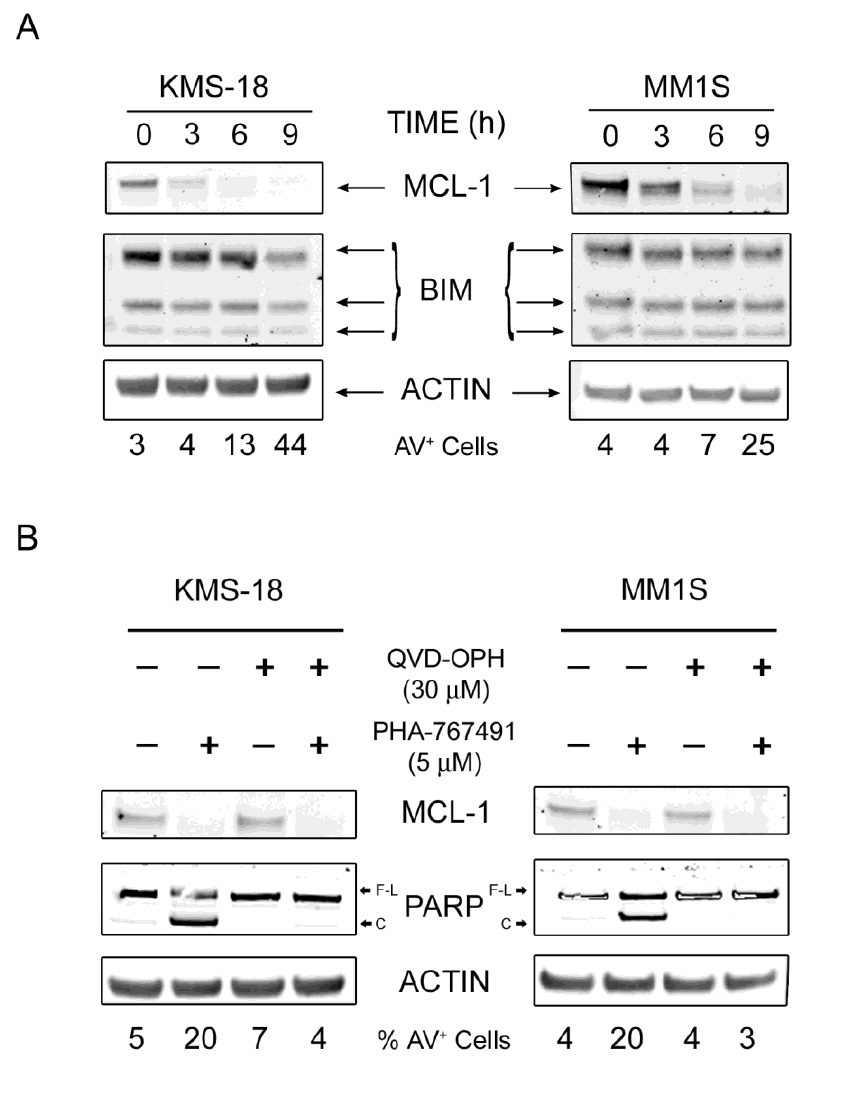
KMS-18 and MM1S from PHA-767491-induced apoptosis (Figure 5A,B) although they reduced bortezomib-induced apoptosis, in particular in MM1S cells (Figure 5C,D). Figure 4. PHA-767491 does not affect BIM levels and causes caspase-independent MCL-1 downregulation. ( A ) KMS-18 and MM1S myeloma cells were incubated with 5 μM PHA-767491 for the indicated time. Protein extracts were prepared and analyzed by immunoblotting using the indicated antibodies; ( B ) KMS-18 and MM1S cells were incubated with 30 μM QVD-OPH for 30 min and then treated with 5 μM PHA767491for 6 h (KMS-18) or 9 h (MM1S). After incubation, protein extracts were prepared and analyzed by immunoblotting using the indicated antibodies. F-L and C in the PARP lane indicate full length and cleaved respectively. Percentage of AV + cells is indicated at the